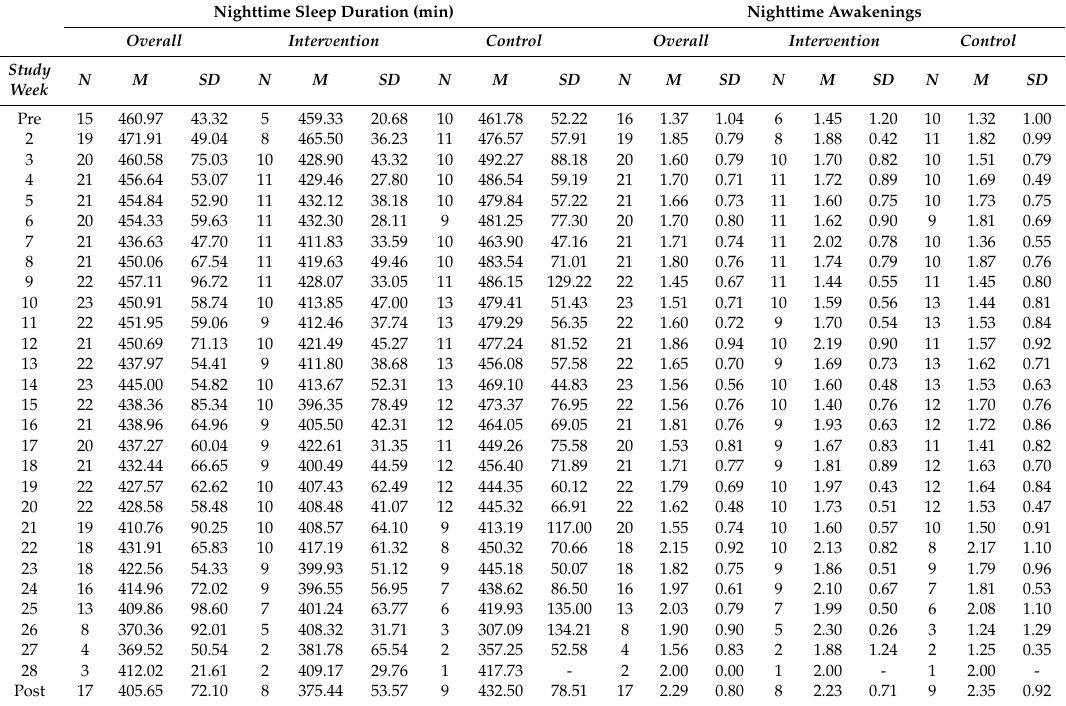
Table 2. Weekly Means and Standard Deviations of Nighttime Sleep Duration and Nighttime